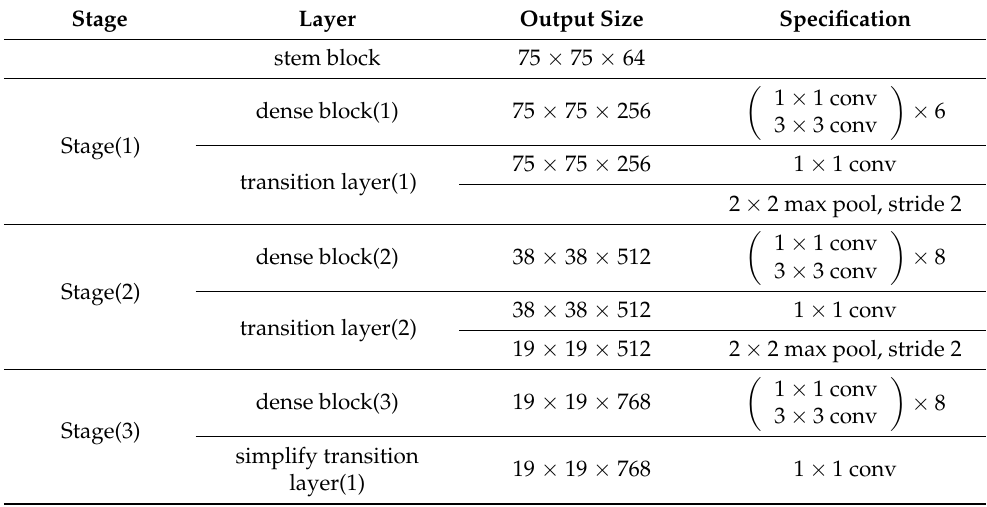
Table 1. Architecture of